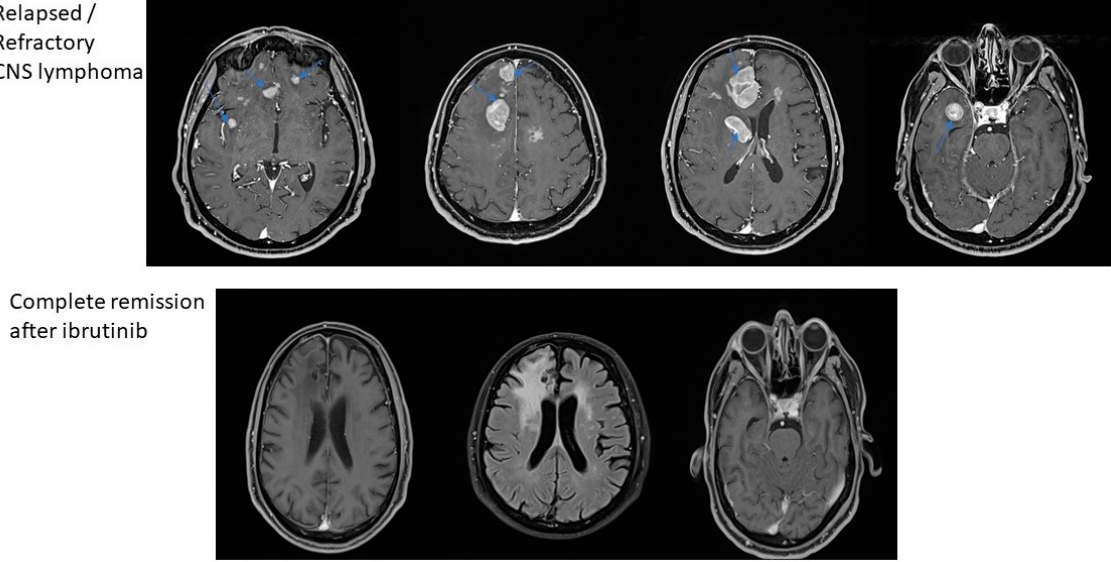
Figure 2. MRI-based remission of CNS lymphomas treated with ibrutinib.